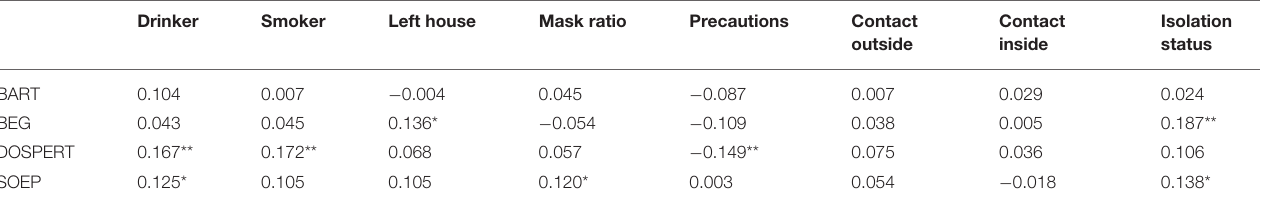
TABLE 7 | Correlation analysis—Pearson correlation coefficients for self-reported real-world risky behaviors for study 2 (UK representative sample) and the individual risk measures. Drinker Smoker Left house Mask ratio